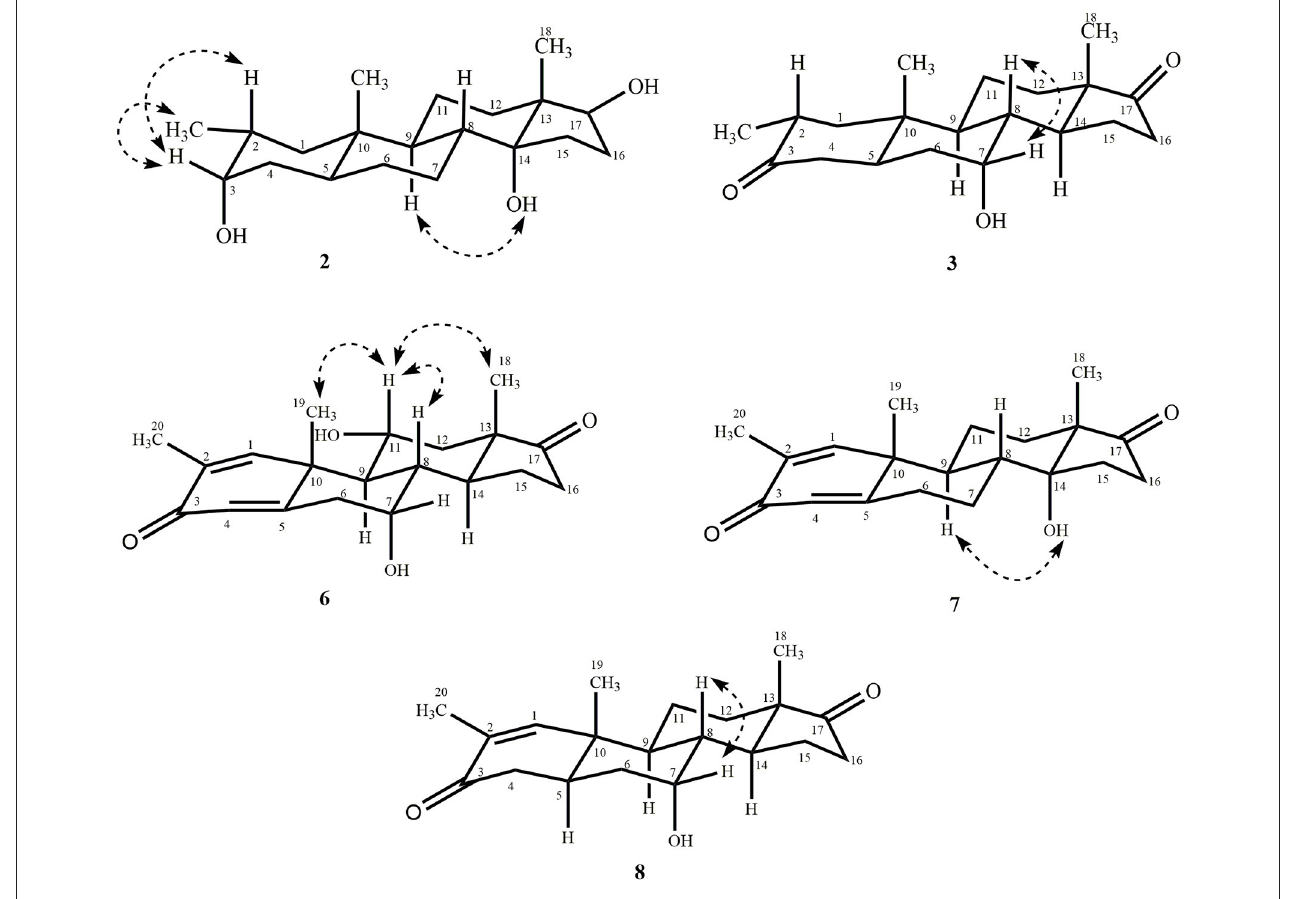
FIGURE 4 | Key NOESY correlations in new metabolites.